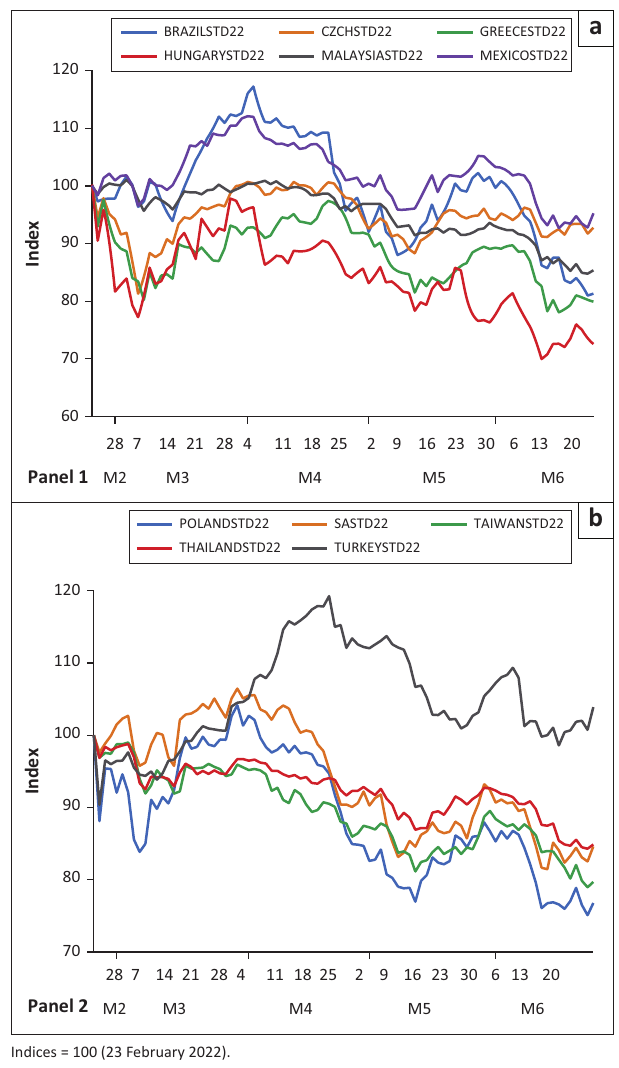
Indices = 100 (23 February 2022). FIGURE 3: Stock market movements since 23 February 2022